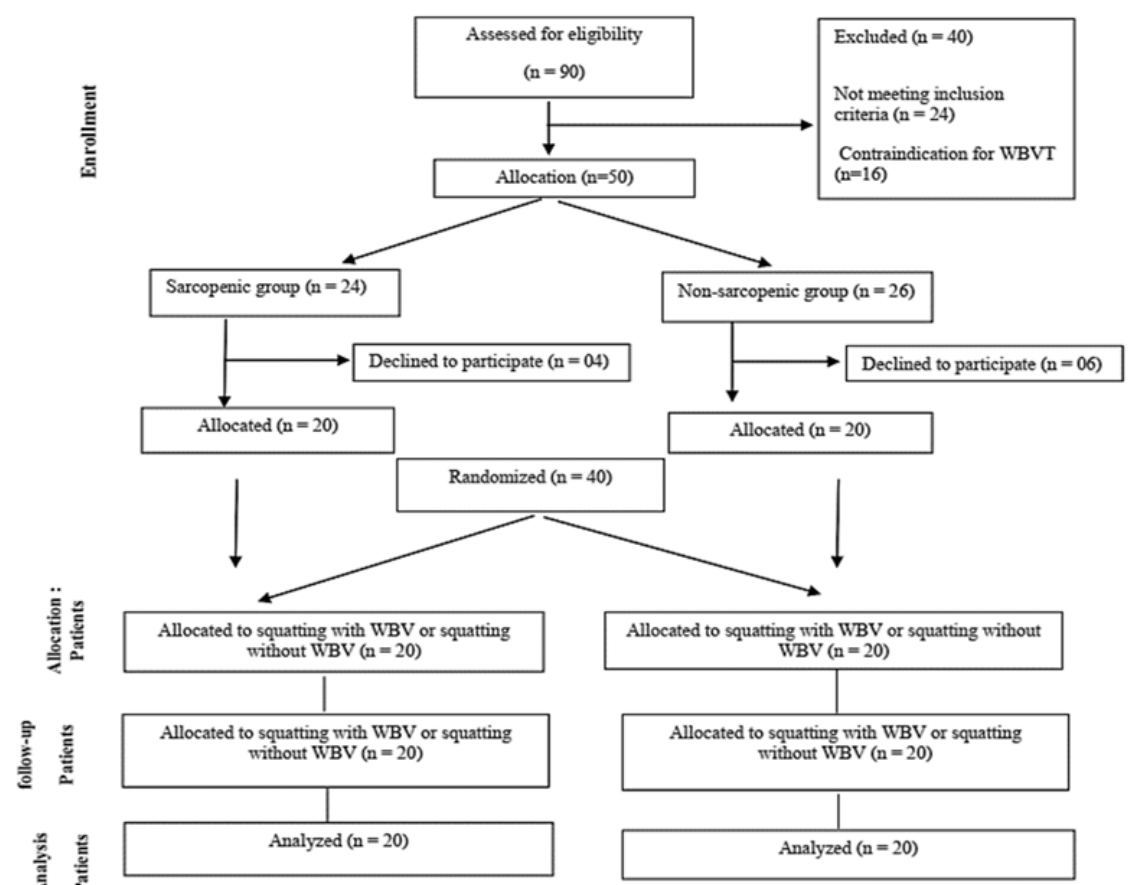
Figure 1. Flowchart of the participants.